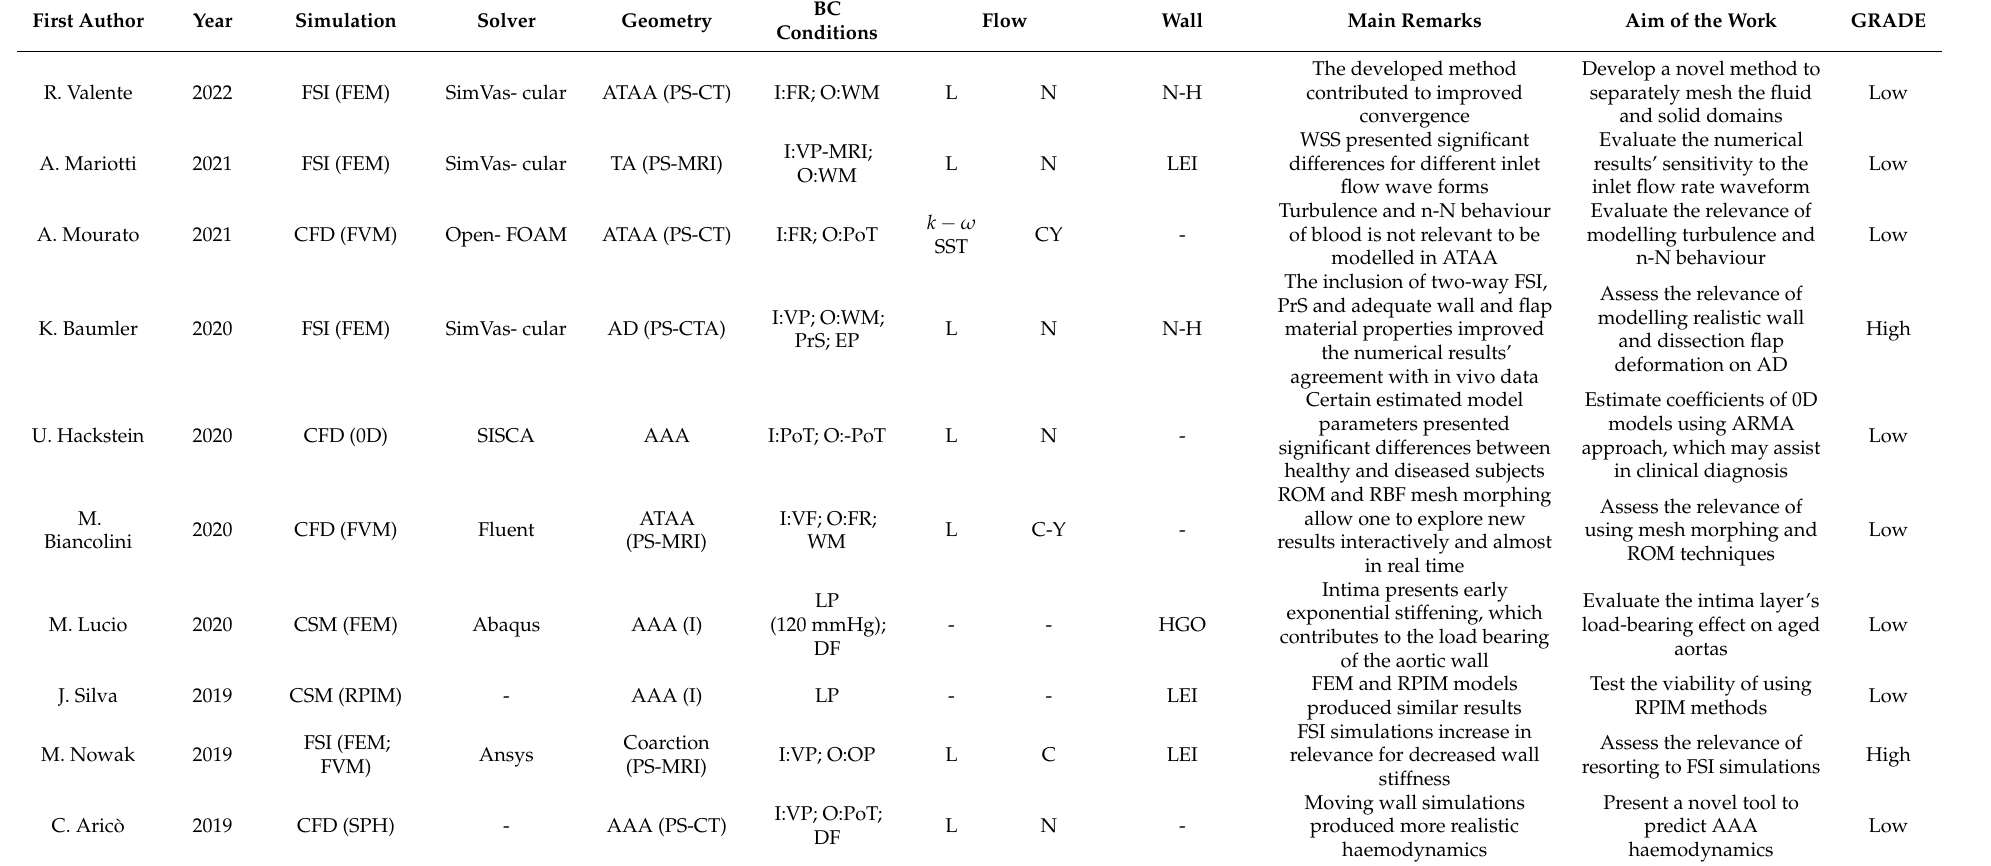
Table 5. Summary of the contributions that aimed to augment numerical modelling of healthy and diseased aortas ( n = 38